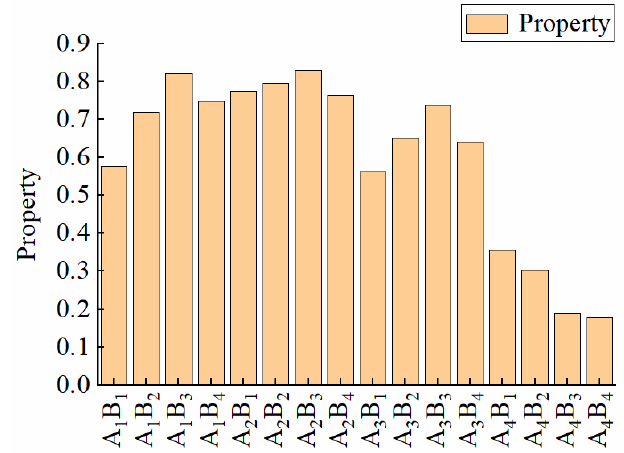
Figure 4. Comprehensive score values of different treatments.